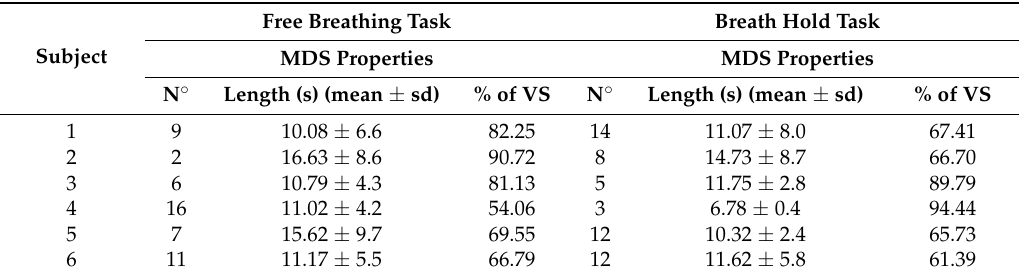
Table 3. Statistics of MDS and VS percentages estimated on acquired EEG data.